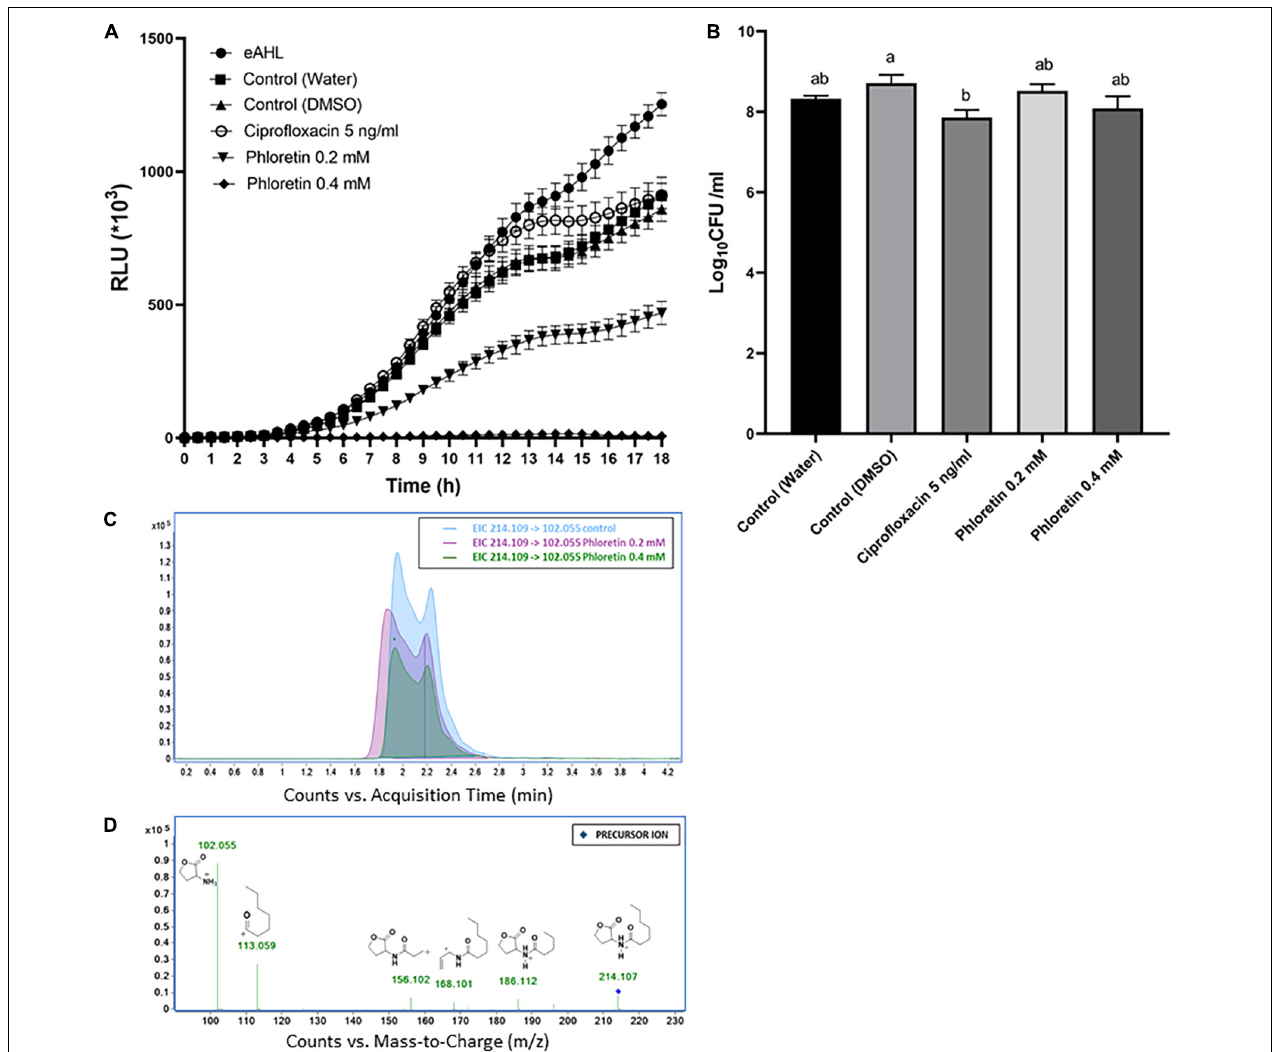
FIGURE 4 | Effects of non-lethal concentrations of phloretin on the synthesis of AHL by Pectobacterium brasiliense (Pb1692). (A) Intensity of the luminescence produced by Escherichia coli pSB401 induced by eAHL and supernatants of Pb1692 grown in the presence of phloretin or ciprofloxacin 5 ng/mL, with dH 2 Oand 0.3% DMSO as controls. Luminescence (250 ms) and absorbance (600 nm) were measured every 30 min for 18 h, and the relative luminescence (RLU = LU/OD 600 ) was calculated. Strain pSB401 supplemented with exogenous N -( β -ketocaproyl)-L-homoserine lactone (eAHL) at 100 nM served as a positive control. (B) Bacterial cells counted by serial dilution (CFU/mL) of Pb1692 cells grown in the presence of increasing concentrations of phloretin (dH 2 O control, 0.2 and 0.4 mM) or ciprofloxacin. Each data point represents the mean ± standard error (SE) of 8 replicates per treatment. Results from one of two independent experiments with similar results are presented. RLU – relative light units. One-way ANOVA with post hoc Tukey-Kramer HSD tests was used to analyze differences. Bars that are not labeled with the same letter are significantly different from each other. (C) Extracted ion chromatogram (EIC) of the protonated precursor ion [214.109, MH+]: 3-oxo-C6-HSL and its corresponding products ions. The x-axis represents retention time (min), and the y-axis represents signal intensity. (D) Fragmentation mass spectra by collision-induced dissociation (MS/MS) of 3-oxo-C6-HSL and metabolites. Precursor ions are indicated by in respective